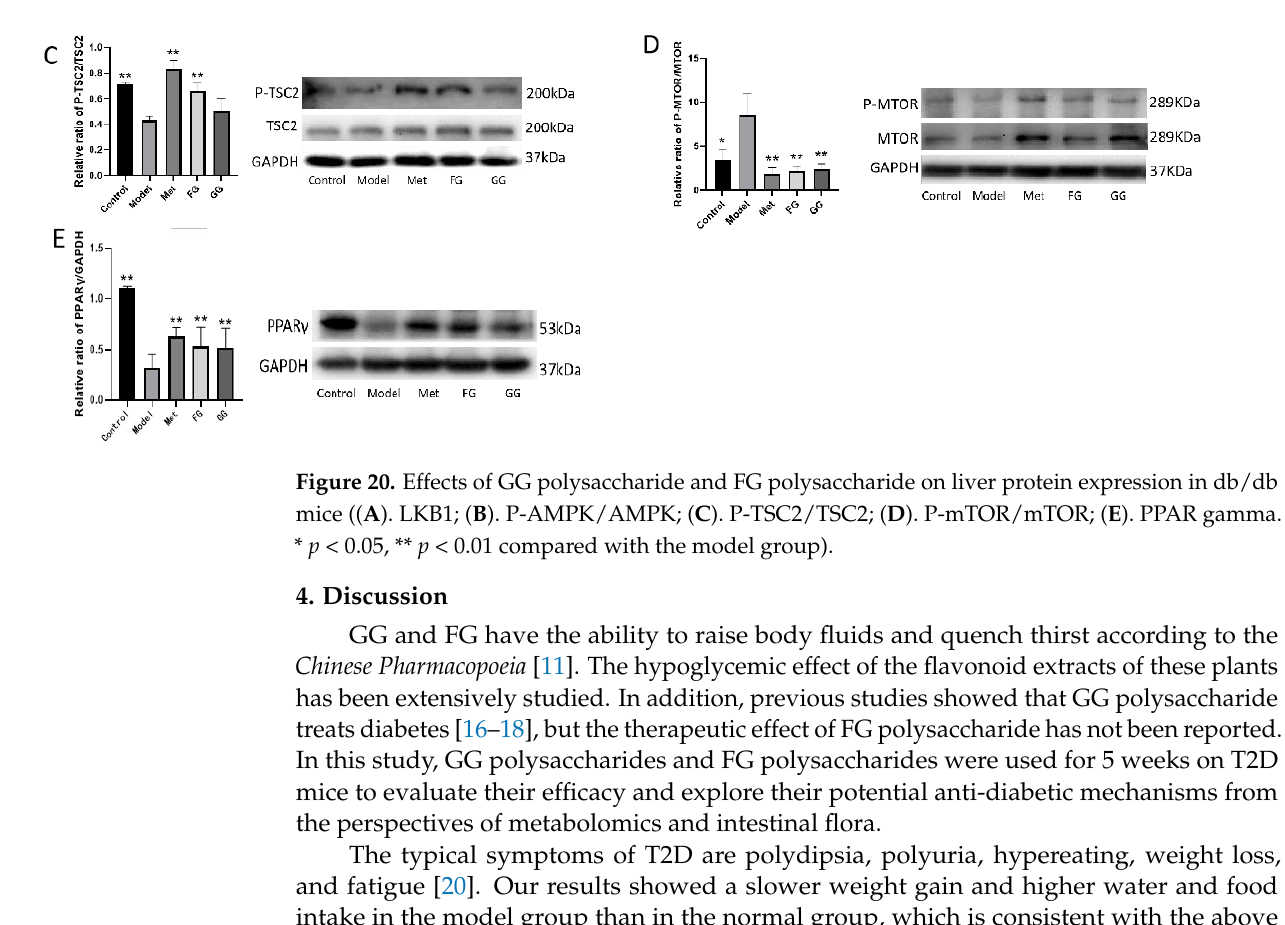
25 of 29 Figure 19. Correlation analysis between the cecal microflora and metabolites affected by Pueraria polysaccharide intervention (( A ): GG; ( B ): FG; red represents a positive correlation, blue repre- sents a negative correlation, * p < 0.05, ** p < 0.01, *** p < 0.001). 3.5. Effects of Pueraria Polysaccharide on the PPAR Signaling Pathway in T2D Mice The protein expression of LKB1, P-AMPK, P- TSC2, and PPARγ in the liver protein of the model group decreased, and the expression of p-mTOR protein increased com- pared with the normal group. The protein expression of LKB1, P-AMPK, P-TSC2, and PPARγ in the liver protein of the model group increased, and the protein expression of P-mTOR decreased after Pueraria polysaccharide intervention compared with the normal group. No significant difference in protein expression was observed between the effect of the GG and FG polysaccharides (Figure 20).